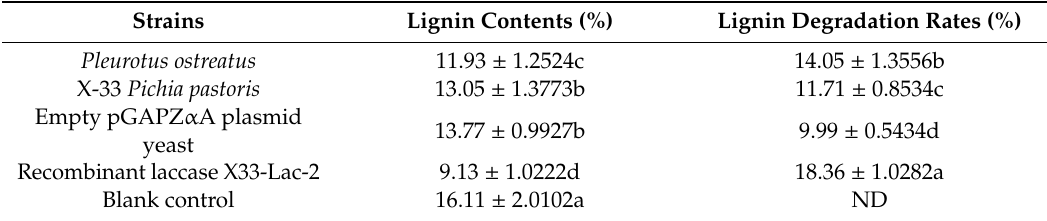
Table 3. The degradation rate of corn stover lignin by di ff erent